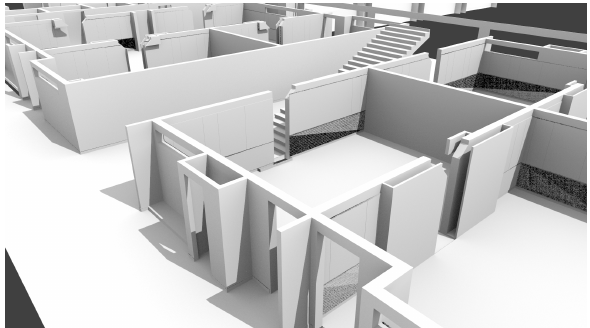
Figure 2. Walls as constructive elements instead of semantic surfaces (the same dataset as in Figure 1). These are supported in the future CityGML 3.0, but may conflict with the well in- grained semantic surface concept in 3D GIS. The image also shows overlap between geometries.